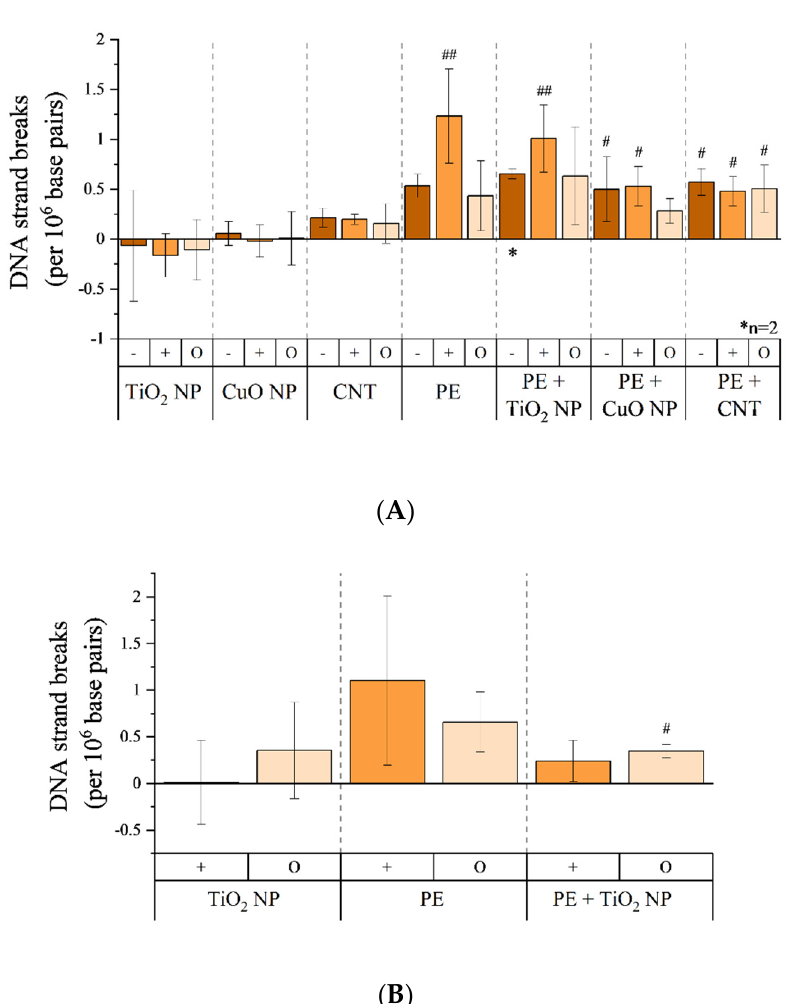
Figure 7. Induction of DNA strand breaks in A549 cells ( A ) and MucilAir™ ( B ) tissue by combustion-generated aerosols. Both cell systems were exposed to aerosols under conditions of normal particle deposition ( − ), increased particle deposition (+), and a filtered aerosol without particle fraction (O) for 4 h, as previously described, and incubated for another 20 h afterward. Subsequently, alkaline unwinding was performed to quantify DNA strand breaks. Results were normalized to a CAC without high voltage (normal particle deposition conditions) for A549 cells and on CAC with high voltage (high particle deposition conditions) for MucilAir™ tissues. Menadione (100 µM) incubated for 1 h was used as a positive control to induce DNA strand breaks (Supplementary Figure S6). If not stated otherwise (*), the mean values of at least three independent experiments ( n = 3) ± standard deviation (SD) are shown. Statistically significant by using one-way analysis of variance (ANOVA), followed by post hoc Dunnett’s test; # p ≤ 0.05; ## p ≤ 0.01. − : normal aerosol exposure; +: